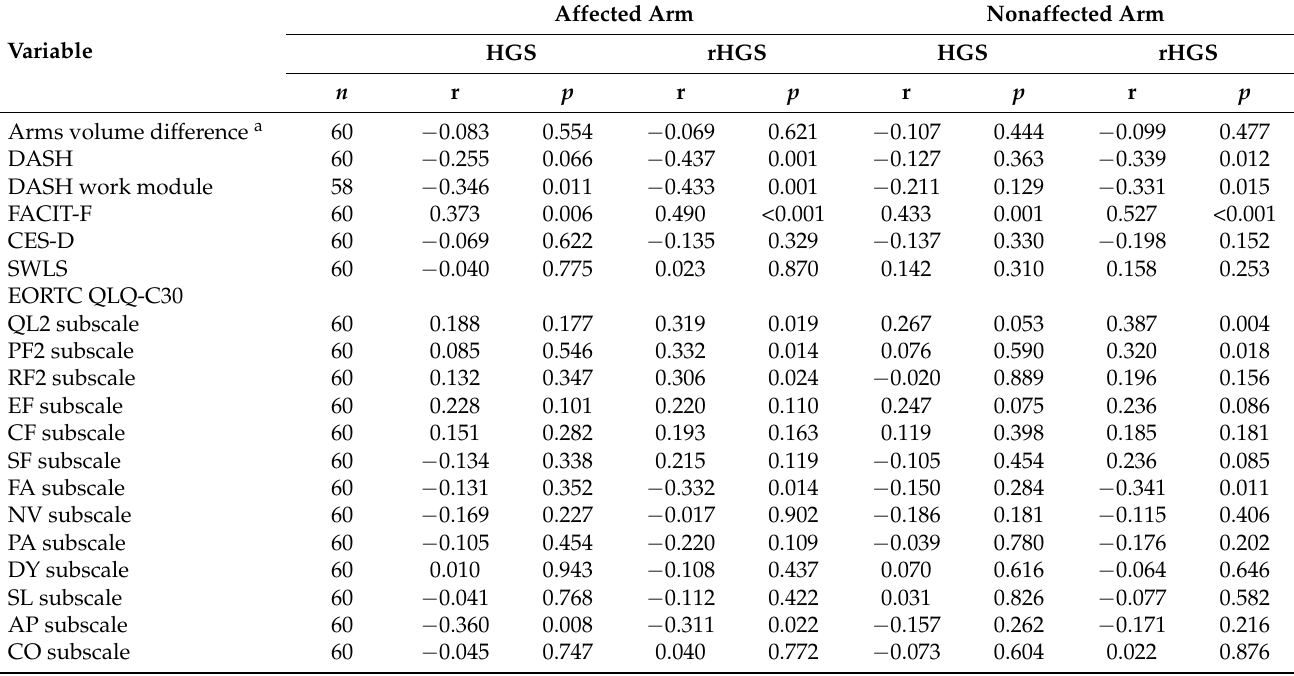
Table A1. Partial correlation assessing the association of HGS, and rHGS of the affected and nonaffected arms with arms volume difference, shoulder–arm disabilities, fatigue, depressive symptoms, life satisfaction and self-reported HRQoL in female survivors of breast